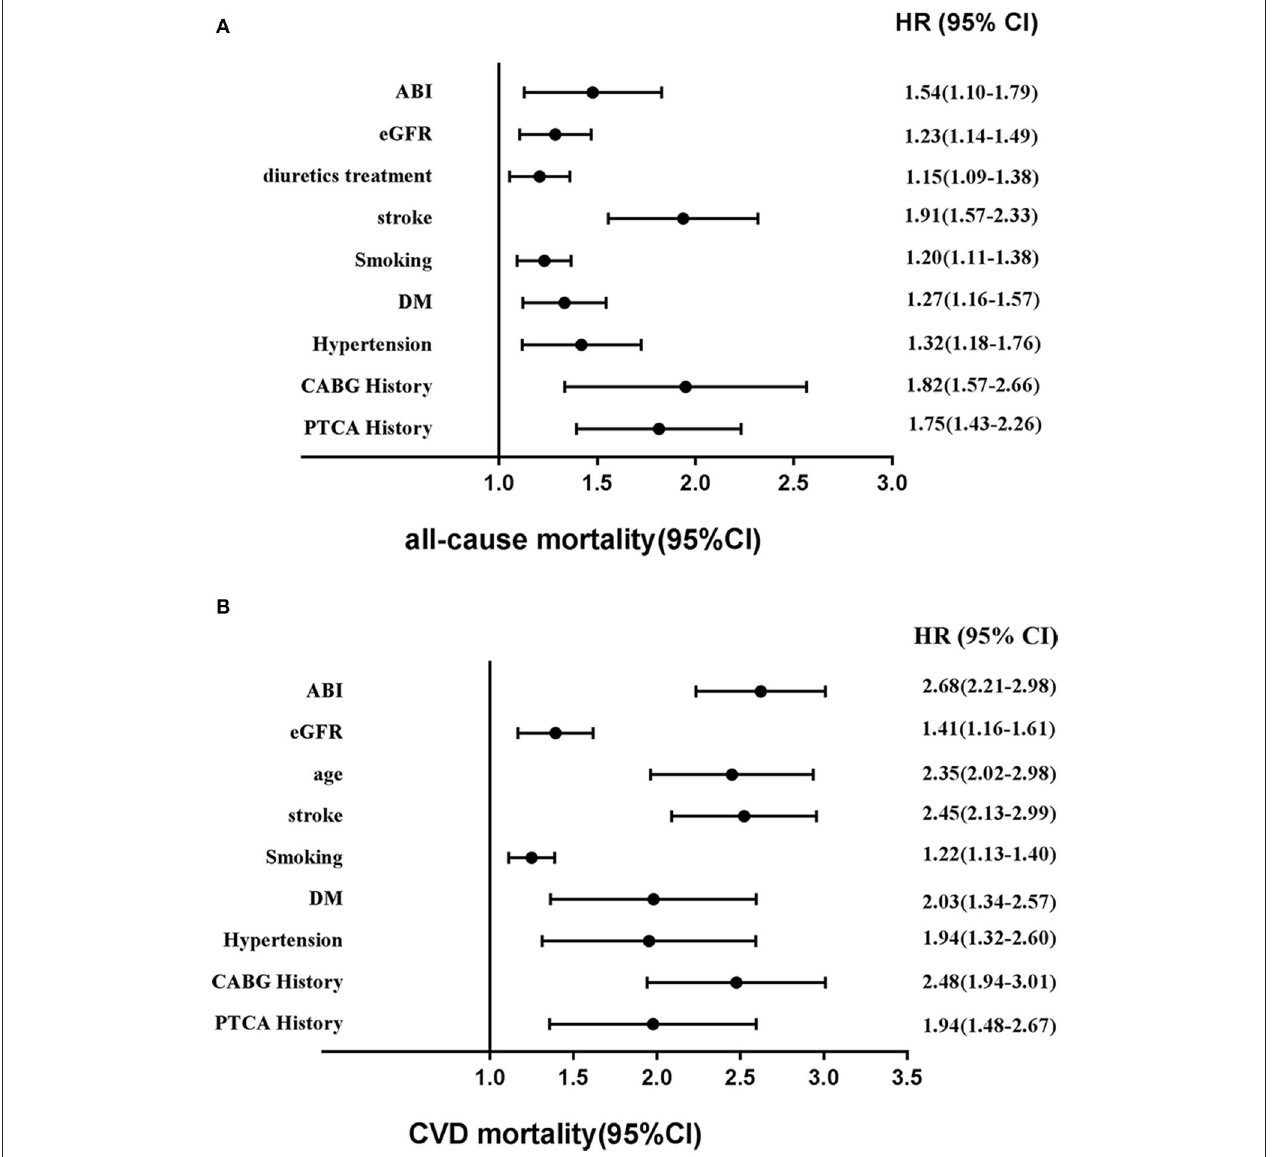
FIGURE 6 | Adjusted other hazards ratios for (A) all-cause mortality and (B) CVD mortality in the cohort study during 6-year follow-up. CVD, cardiovascular disease; HR, hazards ratio; CI, confidence interval; eGFR, estimated glomerular filtration rate; ABI, ankle – brachial